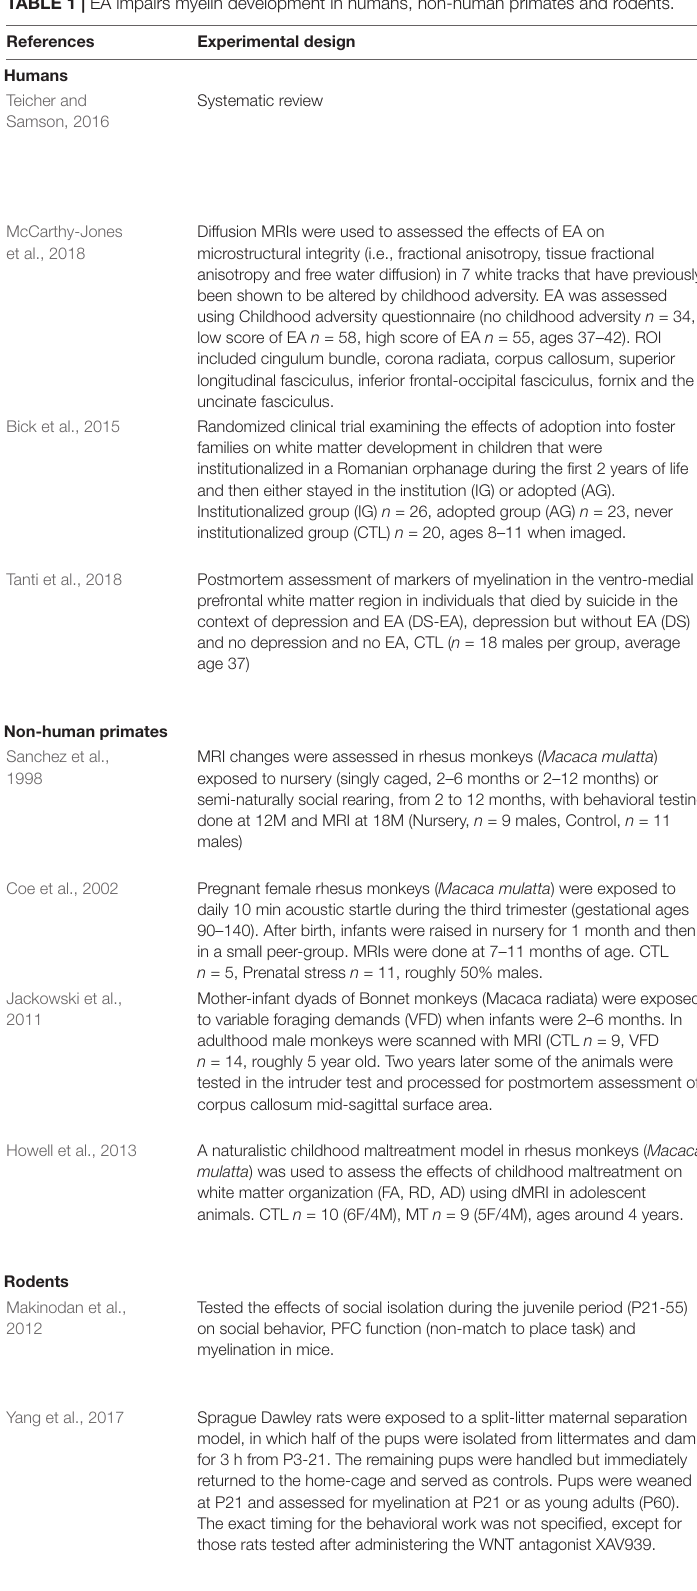
TABLE 1 | EA impairs myelin development in humans, non-human primates and